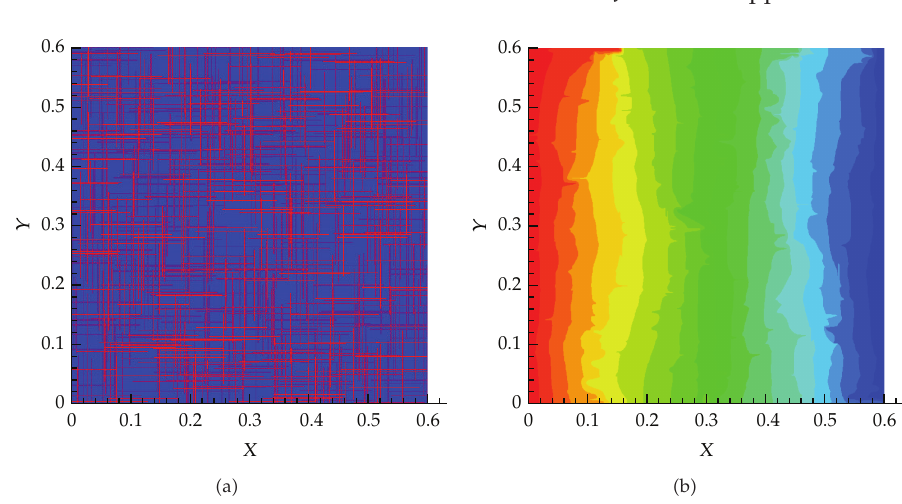
Figure 11: Fractures orientations (cid:2) 800 fractures (cid:3) and pressure contours based on the fine